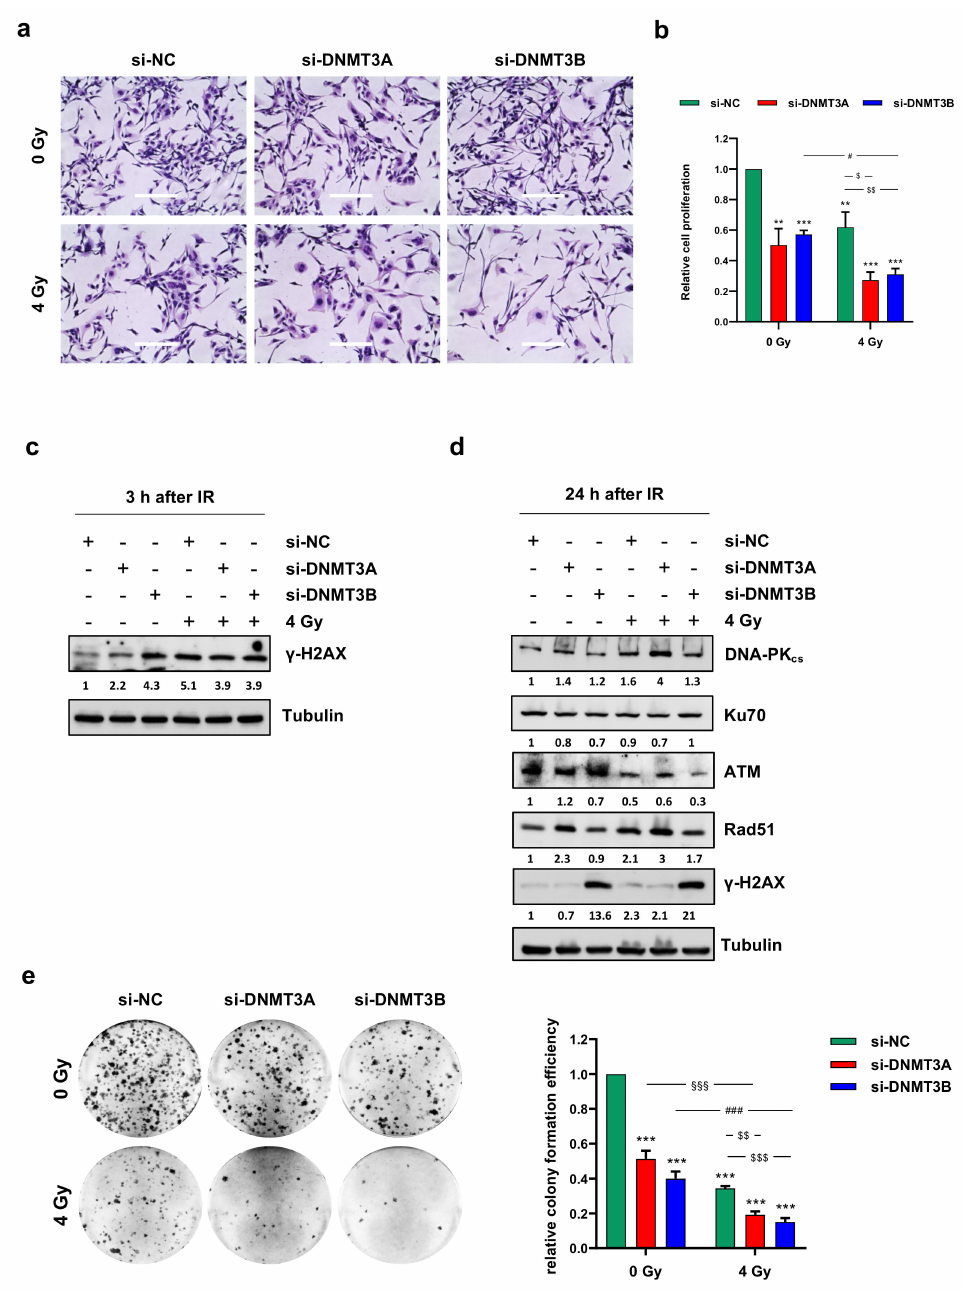
Figure 2. DNMT3A and DNMT3B knocking down increase sensitivity of RMS cells to radiation. ( a ) Representative images of RD cells stained with Giemsa and photographed at 20 × magnification at 144 h after DNMT3A or DNMT3B depletion and 96 h after irradiation. si-DNMT3A samples